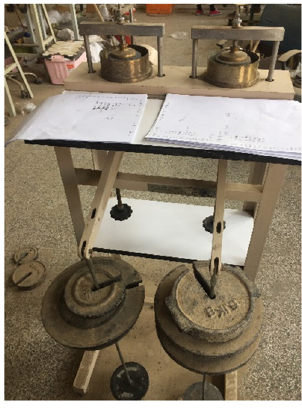
Table 3: Arrangement of samples for uncon fi ned compressive